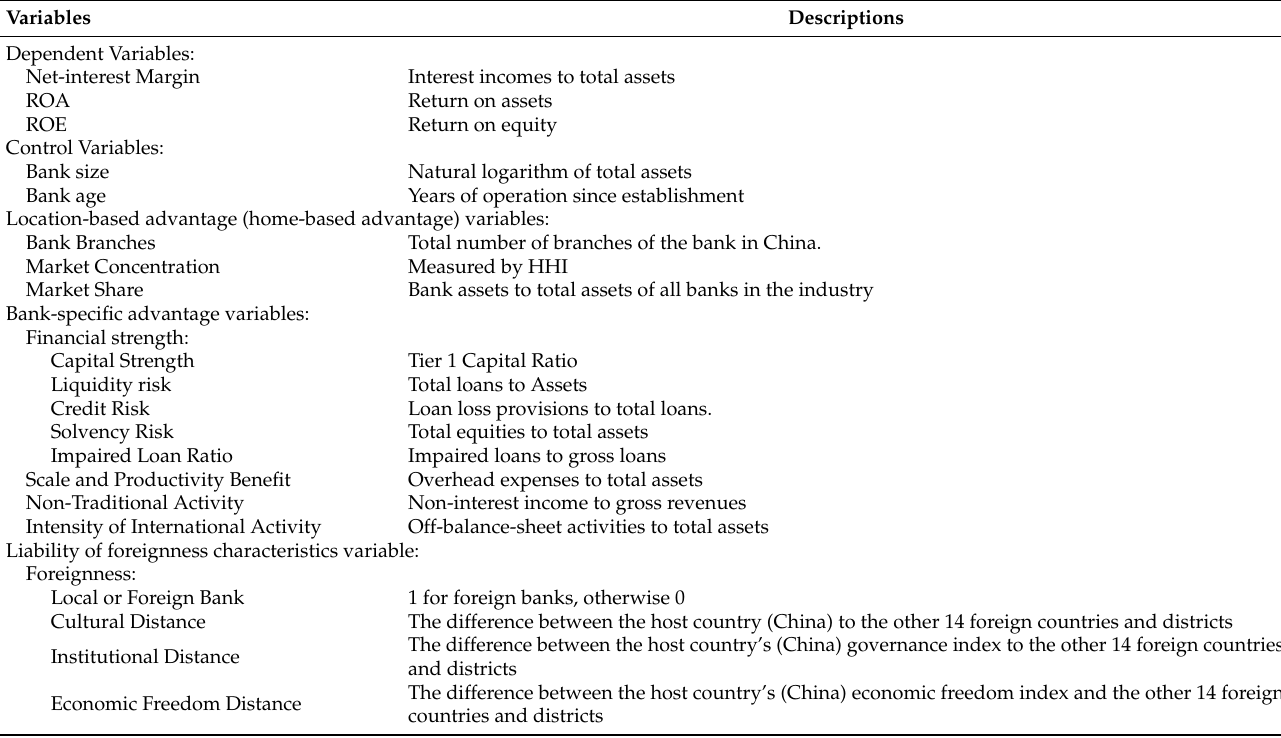
Table 1. Summary description of